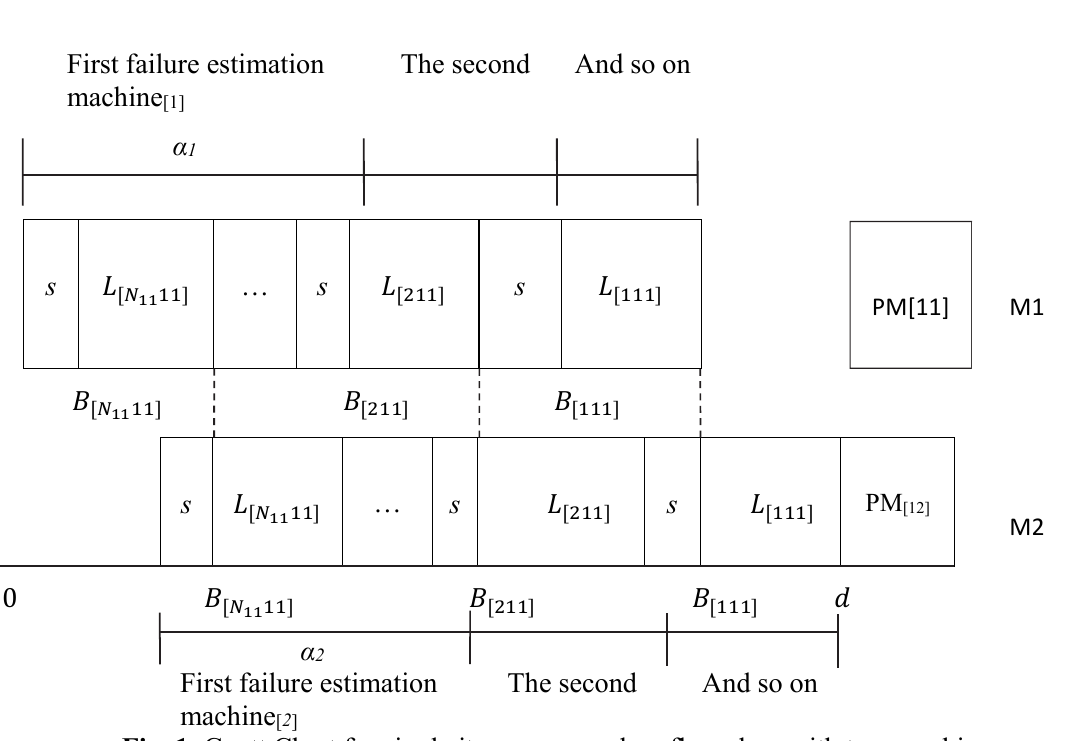
Fig. 1. Gantt Chart for single item processed on flow shop with two